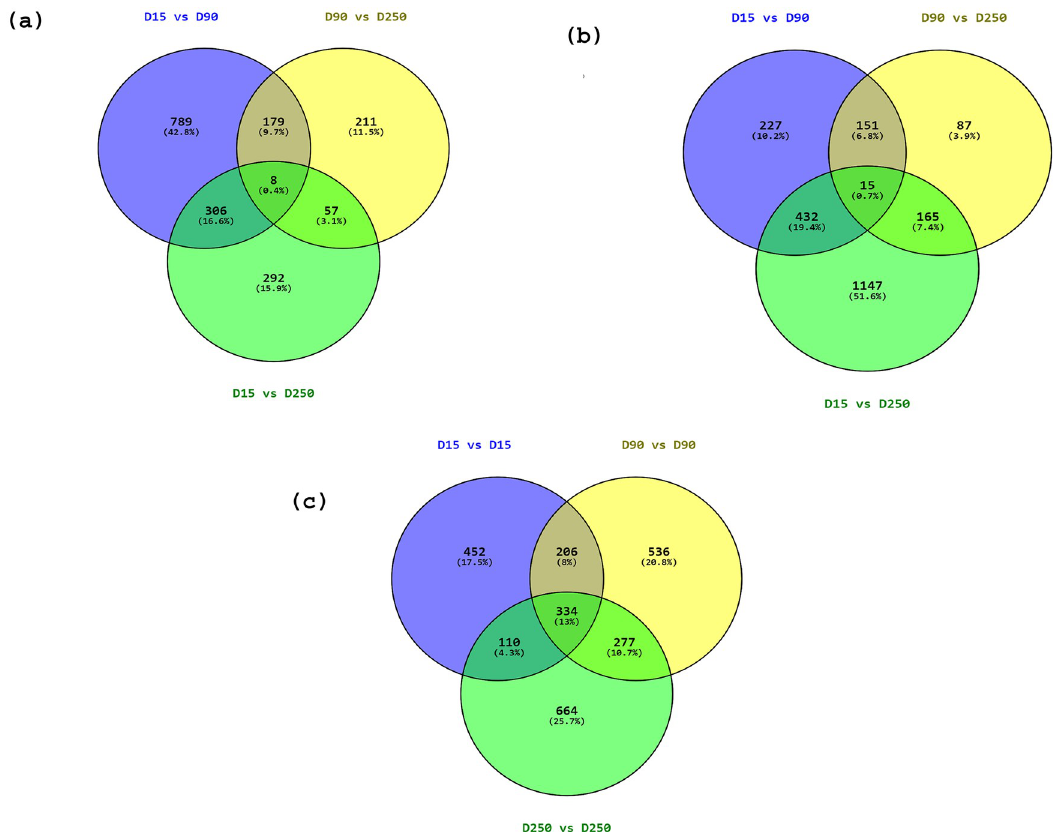
Fig 2. Significantly differentially expressed genes between D15 vs D90, D15 vs D250 and D90 vs D250 in mammary epithelial cells in (a) Kashmiri and (b) Jersey cattle and (c) D15, D90 and D250 between Jersey and Kashmiri